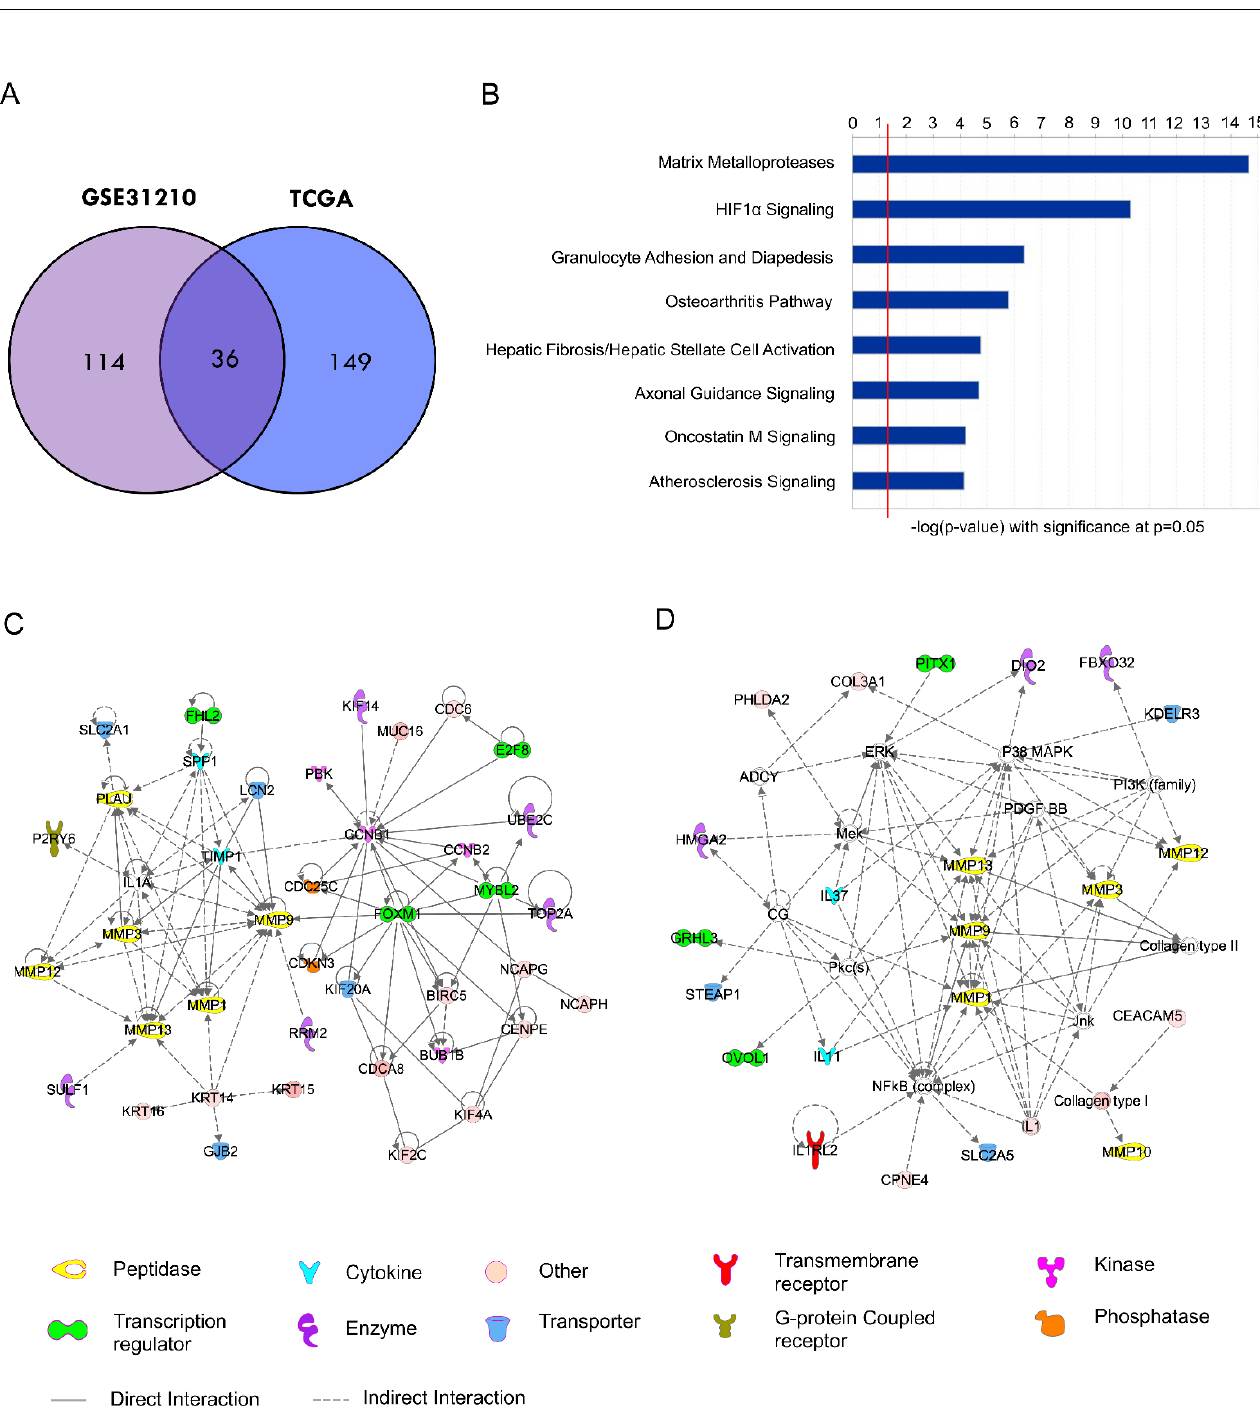
Figure 3. Characteristics of a 36-gene MMP signature and network analysis: ( A ) Venn diagram showed 36 MMP-associated genes, which were shared between MMP-enriched gene clusters in GSE31210 and TCGA cohort. ( B ) Ingenuity pathway analysis of the 36-gene MMP signature showed significant pathways. ( C ) Networks analysis of the 150-gene cluster from the GSE31210 cohort. ( D ) Networks analysis of the 185-gene cluster from the TCGA cohort.